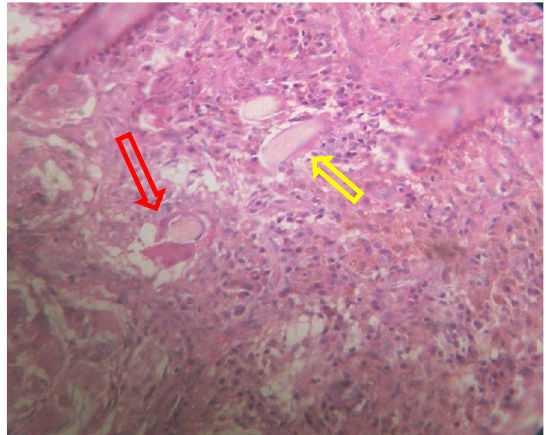
Fig. 4 Granulomatous inflammation composed mainly of foreign body type giant cells (red arrow) and chronic inflammatory cells infiltrate that surrounding hair shafts (yellow arrow) (H&E stain;